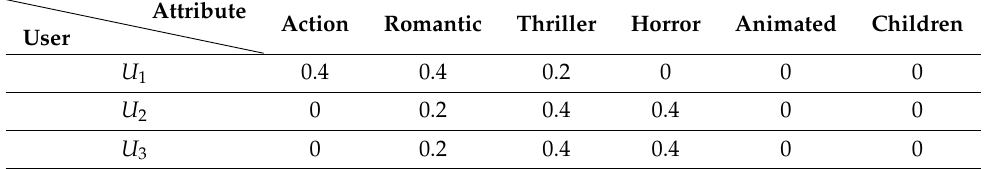
Table 9. User’s interest on items’ categorical attributes.